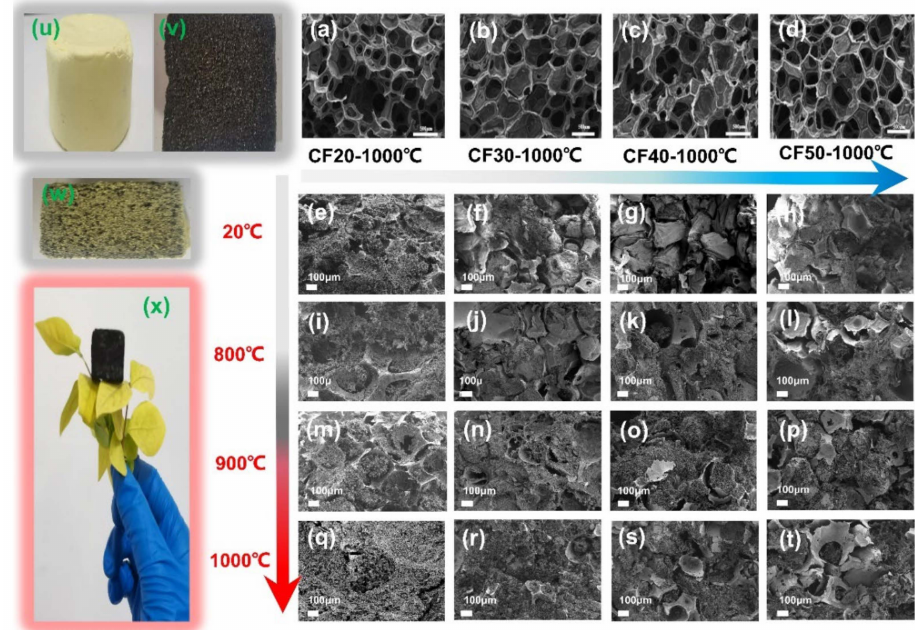
Figure 3. The SEM images of the morphology of carbon foam: ( a ) CF20-1000 ◦ C, ( b ) CF30-1000 ◦ C, ( c ) CF40-1000 ◦ C, ( d ) CF50-1000 ◦ C, and composite: ( e ) CF20-PI, ( f ) CF30-PI, ( g ) CF40-PI, ( h ) CF50 − PI,